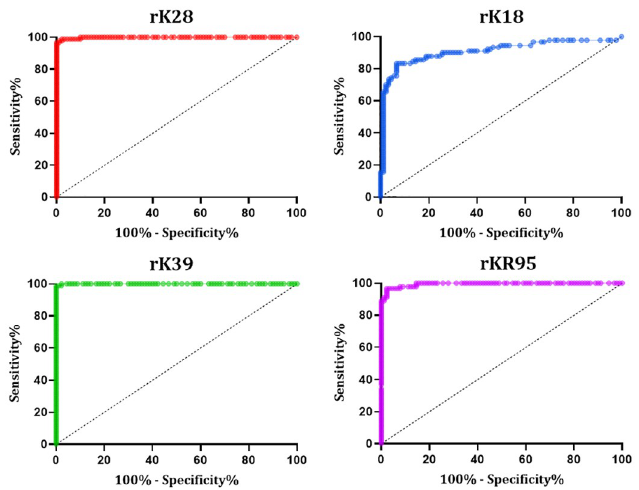
Fig 2. Receiver operating characteristic (ROC) curves to determine ELISA performance. ROC curves were constructed using the values of ABS% Positive obtained from testing samples of VL patients (n = 90) and healthy endemic controls (n = 90) (Panel